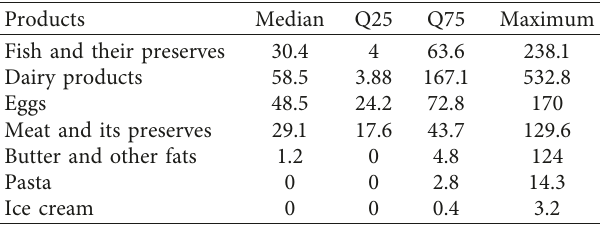
Table 3: The examined group’s vitamin D intake (IU/day) obtained from food products.